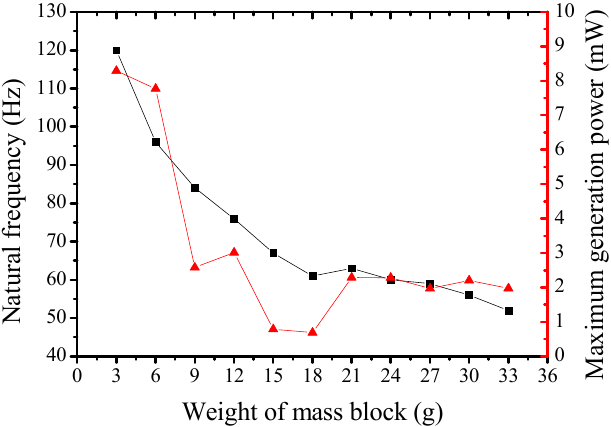
Figure 15. Weight of mass block versus natural frequency and maximum power of PCP in simply supported beam fixation mode.